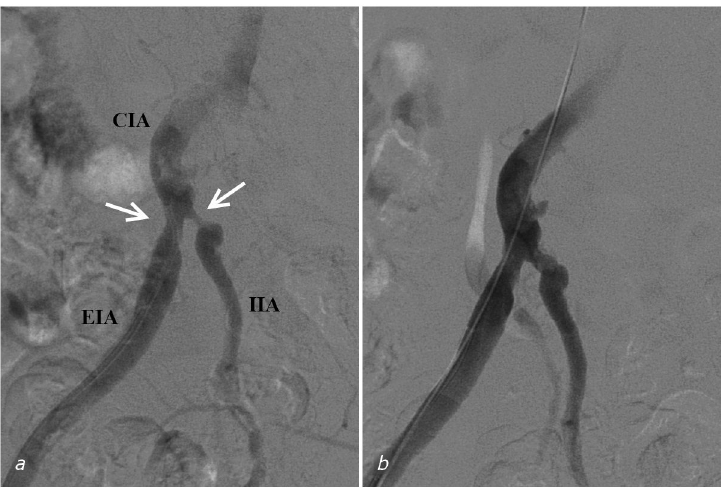
Figure 3. Treatment of a patient (#7) with bilateral buttock claudication and iliac stenoses. (a) Digital subtraction angiography showing the sheath retrogradely advanced to the common iliac artery. Stenoses of the external and internal iliac arteries are visible at their respective origins (arrows). (b) Results of percutaneous transluminal angioplasty of the external iliac artery with a 7 mm balloon and the internal iliac artery with a 4 mm balloon catheter. CIA = Common Iliac Artery. EIA = External Iliac Artery. IIA = Internal Iliac